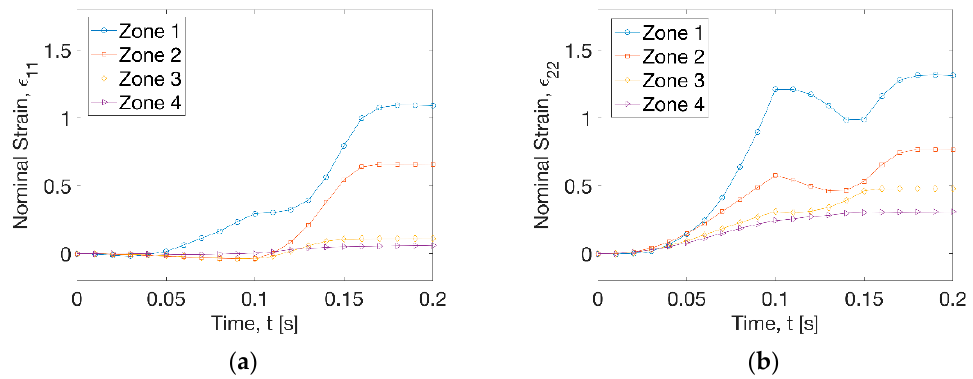
Figure 5. Strain history of 4 zones (T p = 77 °C). ( a ) Hoop strain, ( b ) axial strain.